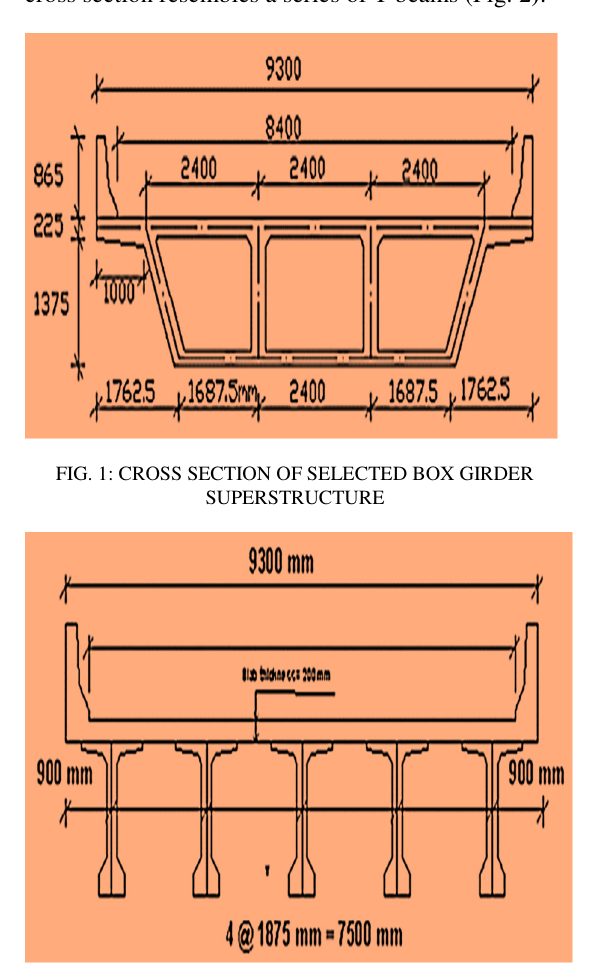
FIG. 2. CROSS SECTION OF SELECTED T BEAM GIRDER